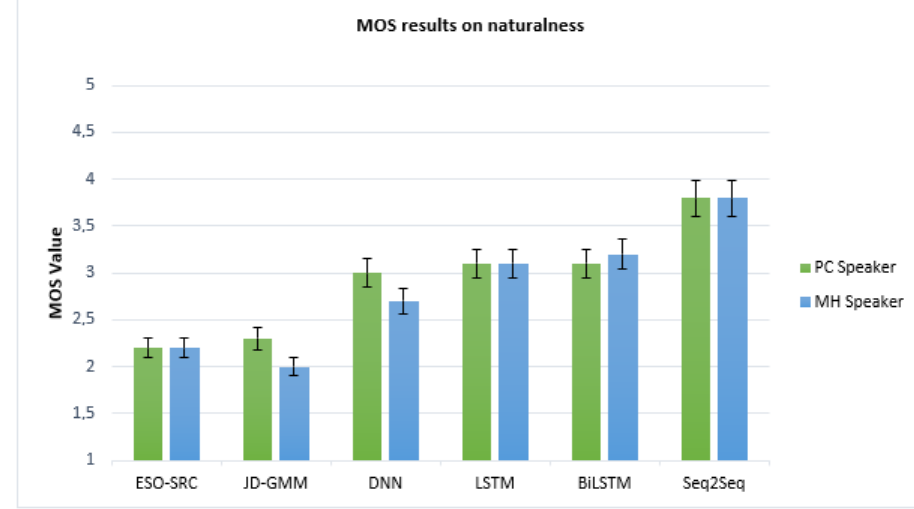
Figure 6. MOS on naturalness test results with 95% confidence interval.